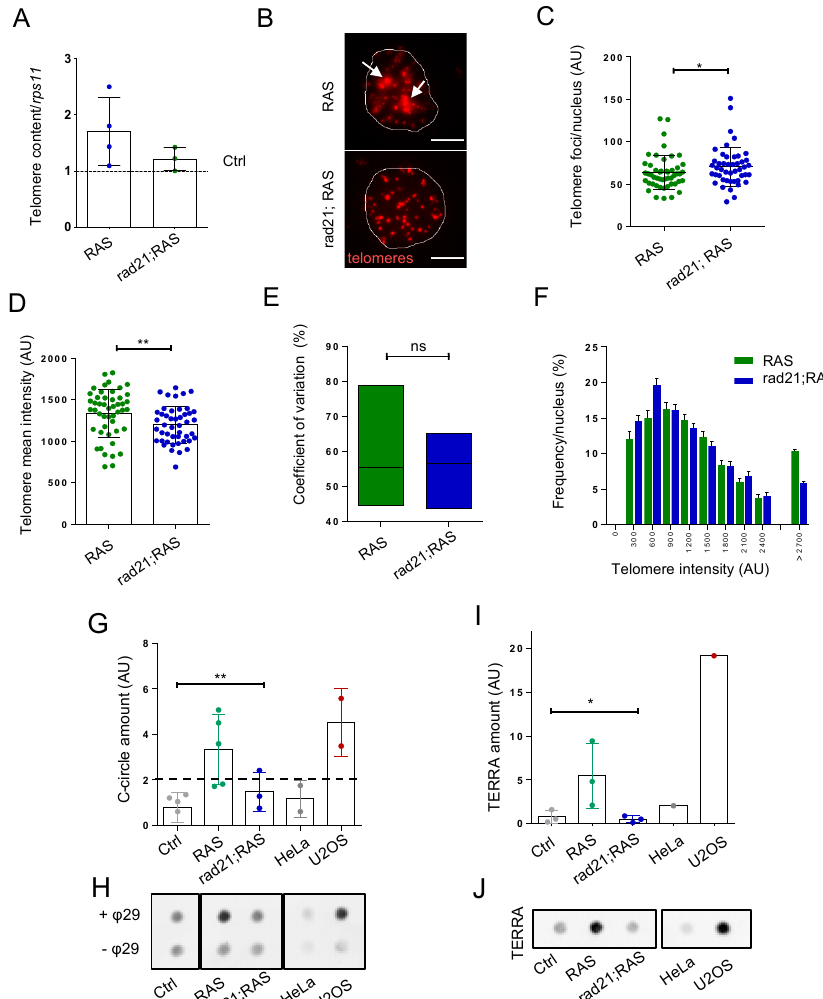
Figure 2. Rad21 depletion prevents ALT, normalize telomere length and reduces TERRA levels in brain tumors. ( A ) Telomere length analysis through telomeric qPCR in RAS, RAS Rad21 +/ − brain tumors compared to control brains (dashed lines). The relative amount was normalized to the signal of a single copy gene ( rps11 ). Each dot represents one sample, n = 3 in all groups. ( B ) Representative fluorescent microscope images of Q-FISH analysis of RAS and rad21;RAS nuclei with ultrabright foci (white arrows). Scale bar: 5 μ m. ( C ) Quantification of the numbers of telomere foci per nucleus and ( D ) quantification of relative telomere length intensity measured by Q-FISH in RAS and rad21;RAS brain tumors. * p < 0.05, ** p < 0.01. RAS n = 48 nucleus; rad21;Ras n = 46 nucleus. ( E ) Analysis of coefficient of variation of telomere mean intensity measured in ( C ) between RAS and rad21;RAS. ( F ) Distribution of telomere length evaluated by Q-FISH ( C ) in RAS and rad21;RAS tumors. The signals >2700 AU could represent ultra-long telomeres or telomeric clusters, an ALT feature. ( G ) Quantification analysis of C-circle assay dot blots (each dot represents one sample). Determination of C-circles amount was calculated after subtracting global background and specific – θ 29 signal. AU: arbitrary unit. ( H ) Representative C-circle assay followed by telomeric dot blot in control, RAS and rad21;RAS brain tumors compared with telomerase+ HeLa cells and ALT+ U2OS cells. Reactions without phy29 polymerase (– θ 29) were included as a control. ( I ) Quantification of TERRA expression measured by dot blot using total RNA (500 ng) of control, RAS, and rad21;RAS brain tumors. As positive and negative control, U2OS and Hela cells were added. ( J ) Representative RNA dot blot hybridization using total RNA (500 ng) of control, RAS, and rad21;RAS brain tumors. As positive and negative control, U2OS and Hela cells were added. For ( G , I ), a minimum of three independent experiments were performed and analyzed with 1 way anova Kruskal–Wallis—non-parametric